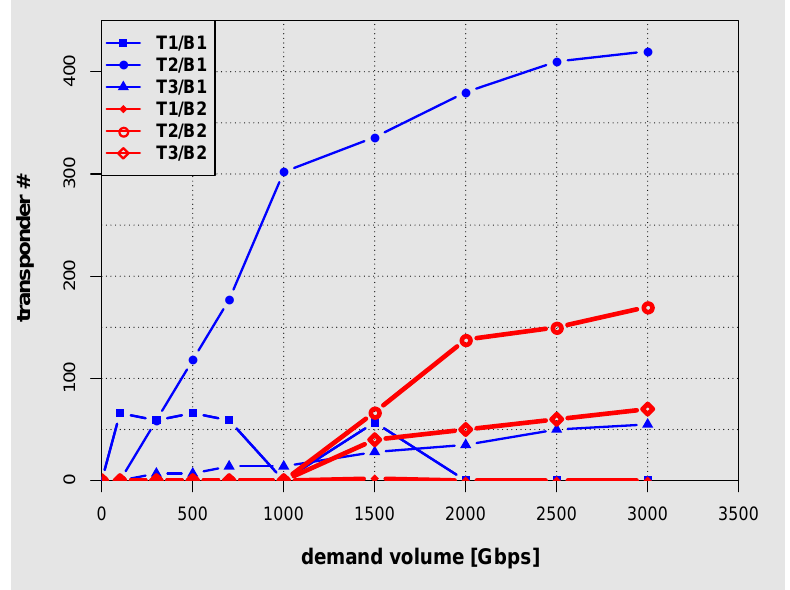
Figure 11. The dependence of number of transponders on the demand volume for American